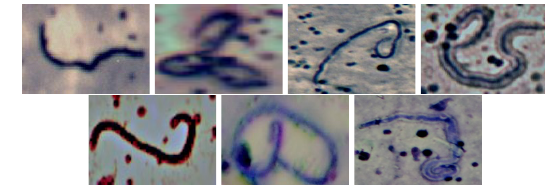
Figure 4: Positive sample